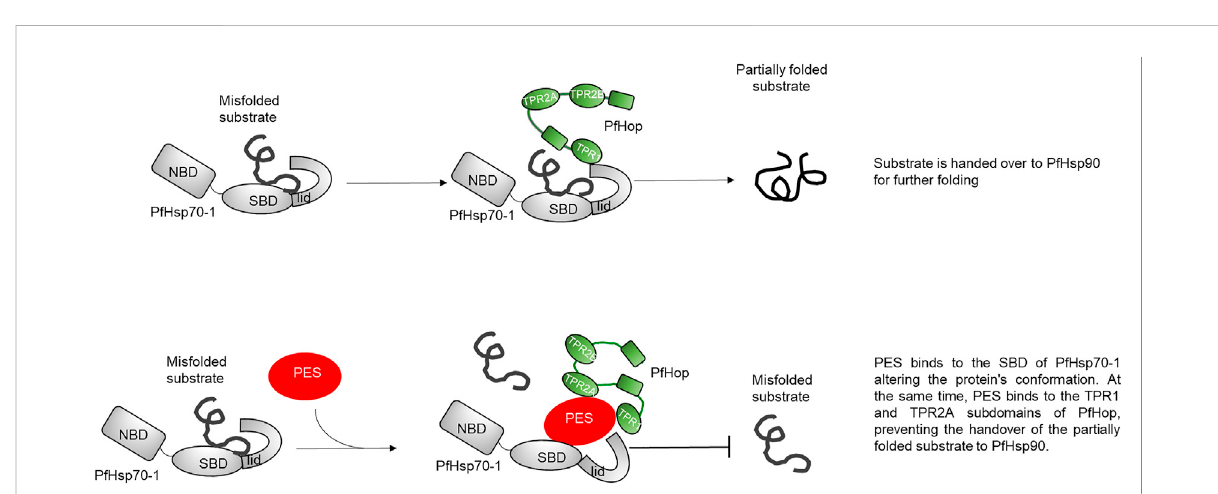
FIGURE 10 Proposed model of PES binding PfHsp70-1. The schematic represents a model for the mechanism of action of PES. The model suggests that PES binds to both PfHsp70-1 and PfHop thereby perturbing the conformations of the two proteins. Consequently, this abrogate the chaperone functionofPfHsp70-1andtheirinteraction.TheinhibitionoftheinteractionofPfHsp70-1andPfHopadverselyimpactsonthefunctionalpartnership between PfHsp70-1 and